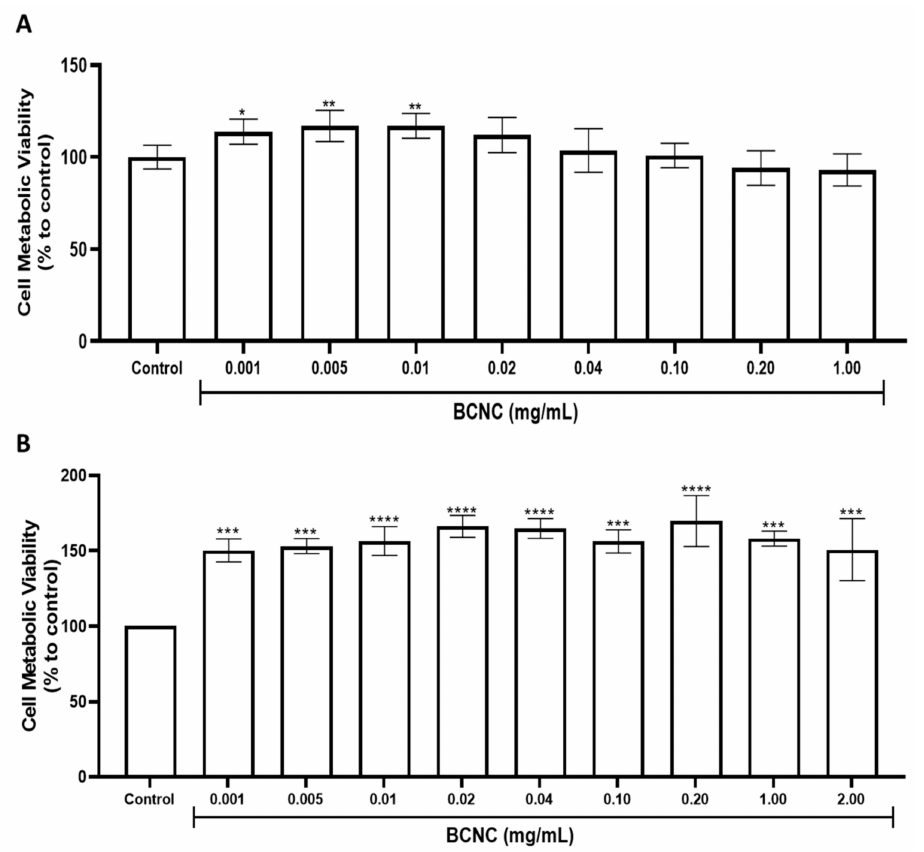
Figure 7. Metabolic viability of ( A ) L929 and ( B ) BMM Φ cells when cultured with increasing doses of BCNC for 24 h, as assessed by the Resazurin assay. PBS was used as the control. Data is expressed as a percentage relative to the control and is the mean ± SD of three independent experiments. All treatment conditions were compared with the control using Dunnett’s multiple comparison